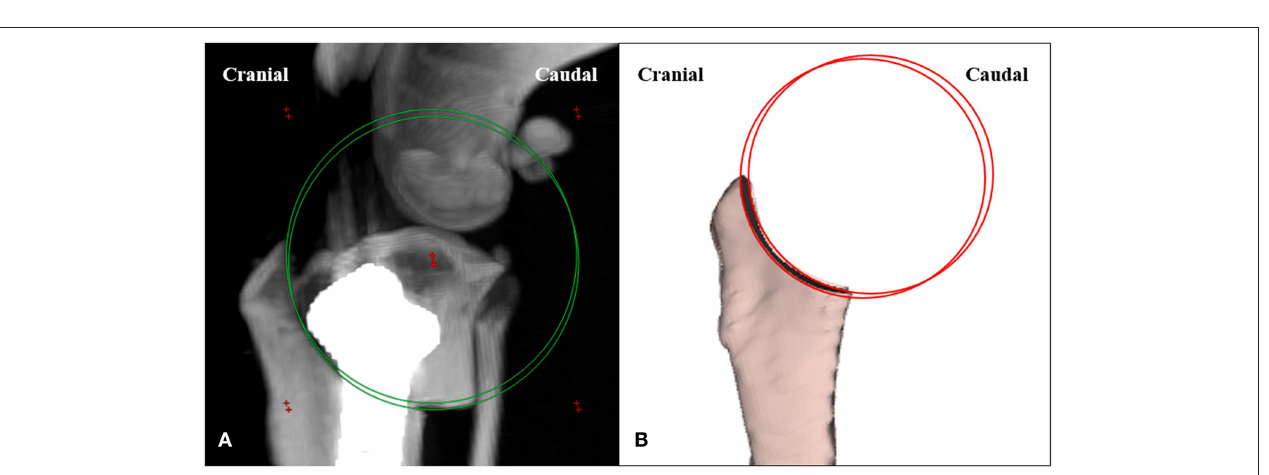
FIGURE 5 | Measuring the angulation of osteotomy for torsion. (A) The distance between the center of the two circles of the corresponding saw blade radius superimposed over the osteotomy from medial and lateral aspects is defined as the osteotomy torsion. (B) The osteotomy lines are identified on the medial and lateral